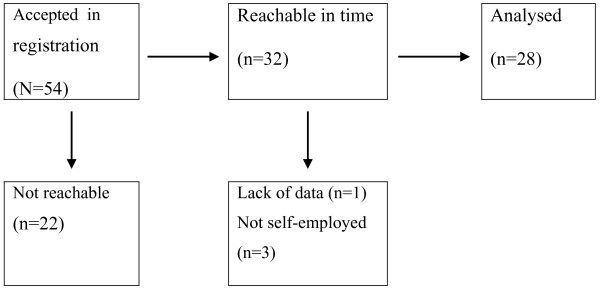
Selection of teams.